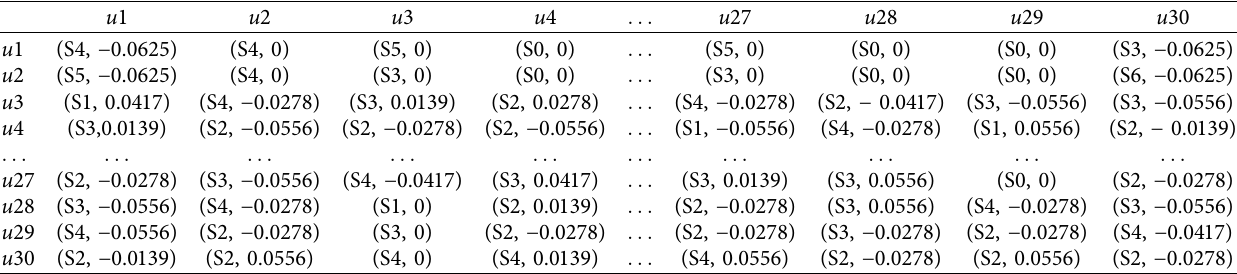
Table 12: Supermatrix.